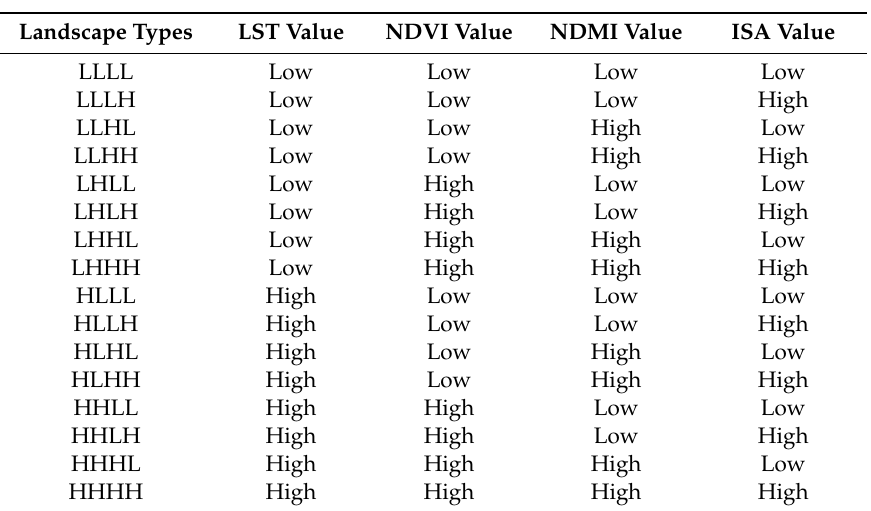
Table 2. Landscape classification in western